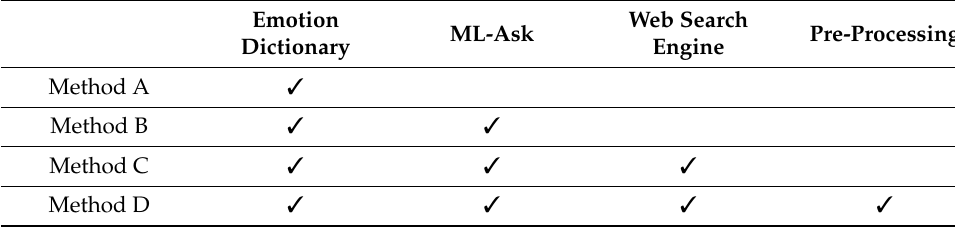
Table 1. Processing techniques used in each